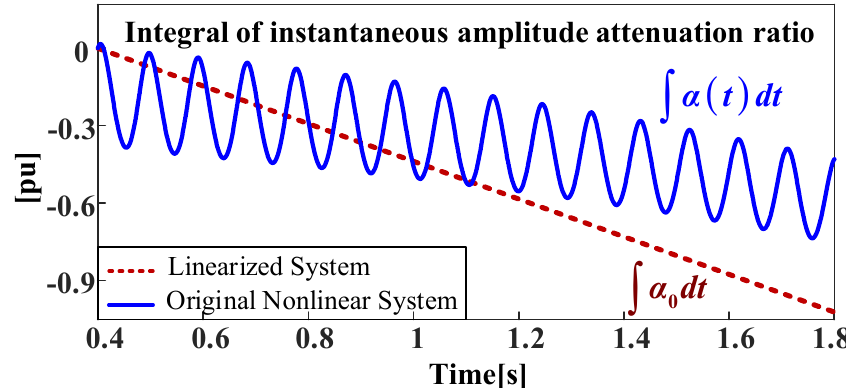
Figure 16. Integral of instantaneous amplitude attenuation ratio.